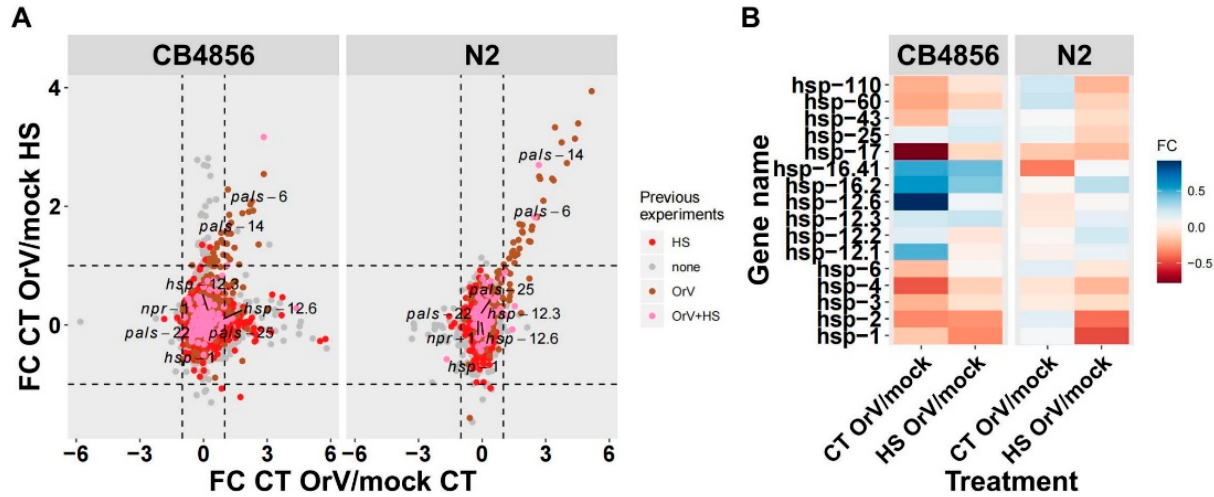
Figure 3. Impact of HS on OrV-induced gene-expression. ( A ) The log 2 fold-change (FC) expression ratio between OrV- infected and mock-infected samples measured in CB4856 and N2. For each treatment-strain, combination n = 1 was used and measured by microarray. Each dot represents a gene and was given a color coding when detected in OrV literature (brown), HS experiments (red), both (pink), or none (grey). Labels of gene-names were added based on experiments presented in this paper. The dashed lines indicate a cut-off of |FC| > 1. ( B ) A heat-map of the FC expression differences of the hsp -genes. Blue indicates higher expression upon OrV-infection, and red indicates decreased expression.